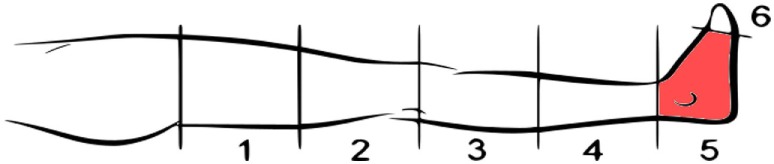
Representation of the phantom limb pain location in the lower-limb amputee subject treated with phantom motor execution.